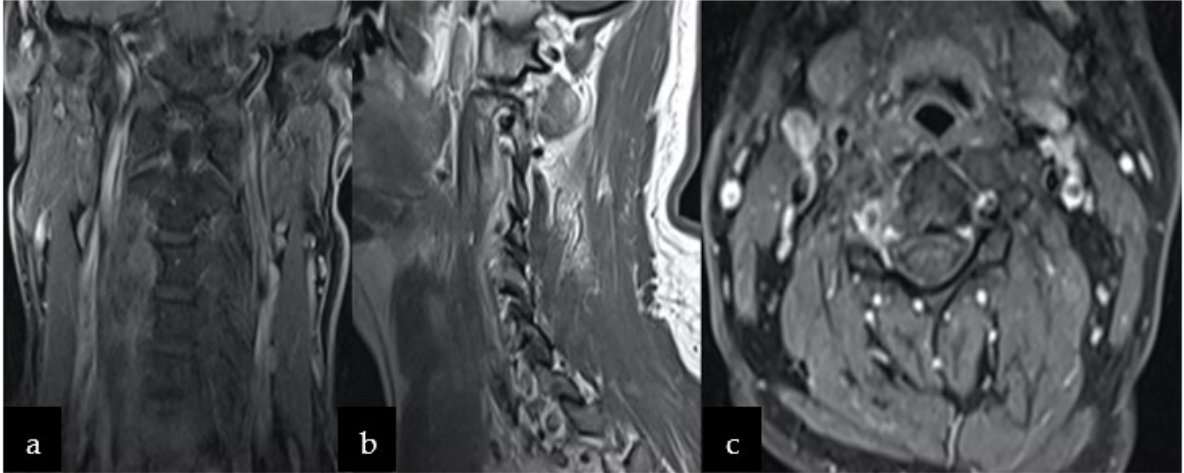
Figure 3. Microscopic images: ( a ) Hematoxylin–eosin stain, neoplastic cells with pale eosinophilic, cytoplasm vacuolated, arranged in cords separated by fibrovascular bands and myxoid matrix. Immunoreactivity for ( b ) AE1/AE3, ( c ) S100, and ( d ) negative one for GFAP.